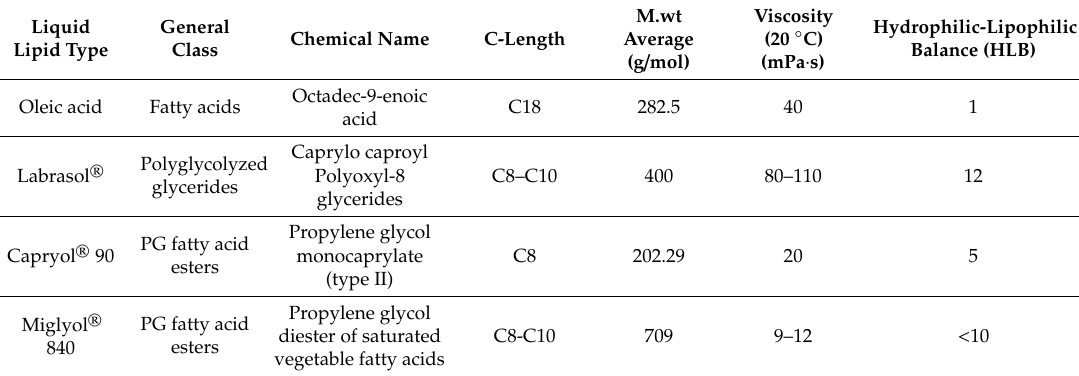
Table 4. Physicochemical properties of liquid lipids used in the preparation of